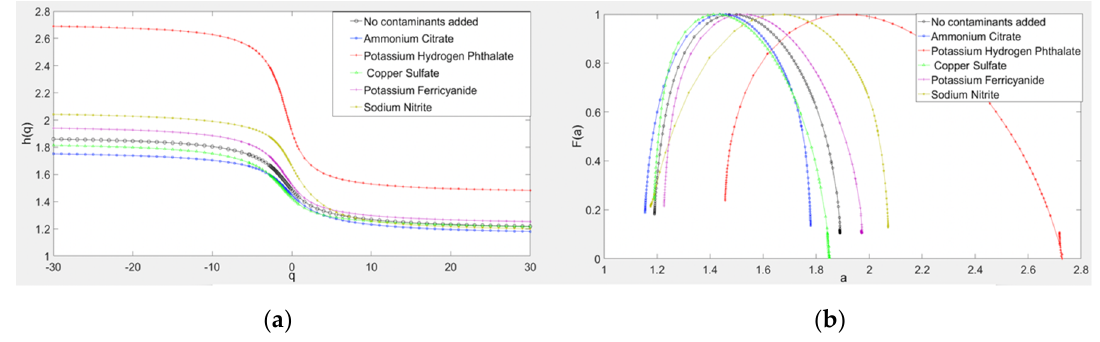
Figure 4. ( a ) Hurst graph of Nitrate Nitrogen; ( b ) multifractal singular spectrum of Nitrate Nitrogen. Table 3. The results of single indicator fluctuation